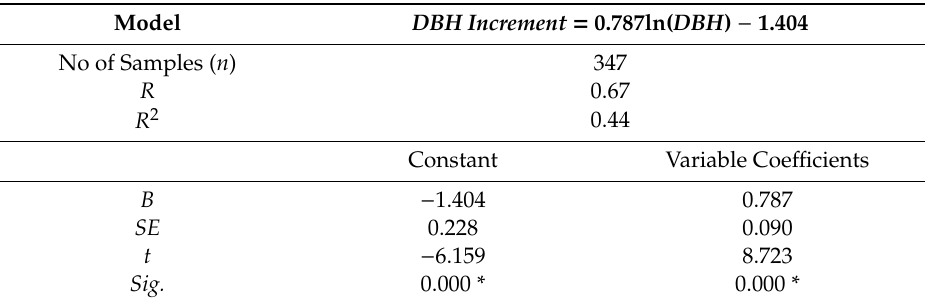
Table 1. Regression Statistics of Diameter at Breast Height (DBH) Increment Estimation Model.